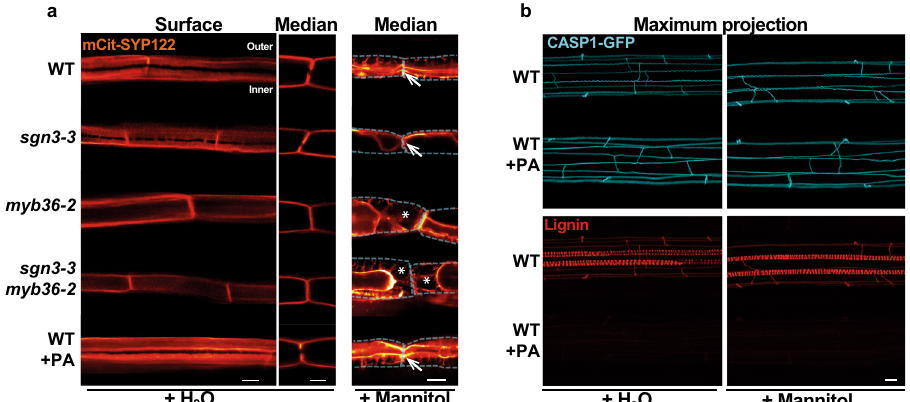
Fig. 4 PM attachment to the CW is MYB36-dependent but does not rely on lignin deposition. a Median and surface view of the endodermal plasma membrane using the marker line pELTP::SYP122-mCitrine before plasmolysis ( + H 2 O) and after plasmolysis ( + Mannitol) at 15 cells after the onset of elongation. WT plants were treated or not from germination with 10 µ M piperonylic acid ( + PA). White asterisks show the exclusion domain at the CSD. The dashed line represents the contours of the cells before plasmolysis. Arrows show the plasma membrane attachment to the cell wall. Blue asterisks show the plasmolysis generated space where no attachment is observed. Scale bar = 5 µ m. “ inner ” designates the stele-facing endodermal surface, “ outer ” , the cortex-facing surface. The experiment was repeated three times independently with similar results. b Maximum projection of CASP1-GFP and lignin staining with basic fuchsin in cleared roots from plants grown with or without 10 µ M piperonylic acid and subjected to plasmolysis with Mannitol. Scale bar = 10 µ m. The experiment was repeated two times independently with similar